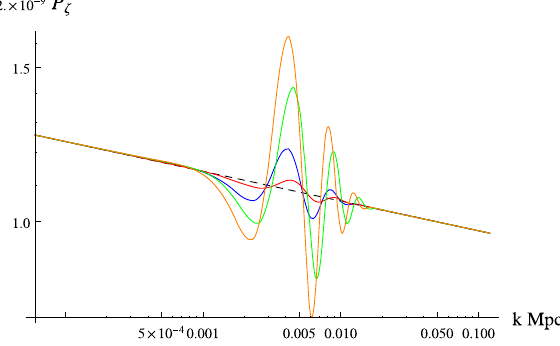
Fig. 2 The power spectrum of primordial curvature perturbations P ζ is plotted for λ = − 4 × 10 − 12 ,σ = 0 . 05, and k 0 = 1 . 2 × 10 − 3 ( blue ), λ = − 10 − 12 ,σ = 0 . 05, and k = 1 . 3 × 10 − 3 ( red ), λ = − 10 − 11 ,σ = 0 0 . 04, and k 0 = 1 . 3 × 10 − 3 ( green ), and λ = − 1 . 5 × 10 − 11 ,σ = 0 . 04, and k 0 = 1 . 2 × 10 − 3 ( orange ). The dashed lines correspond to the featureless spectrum